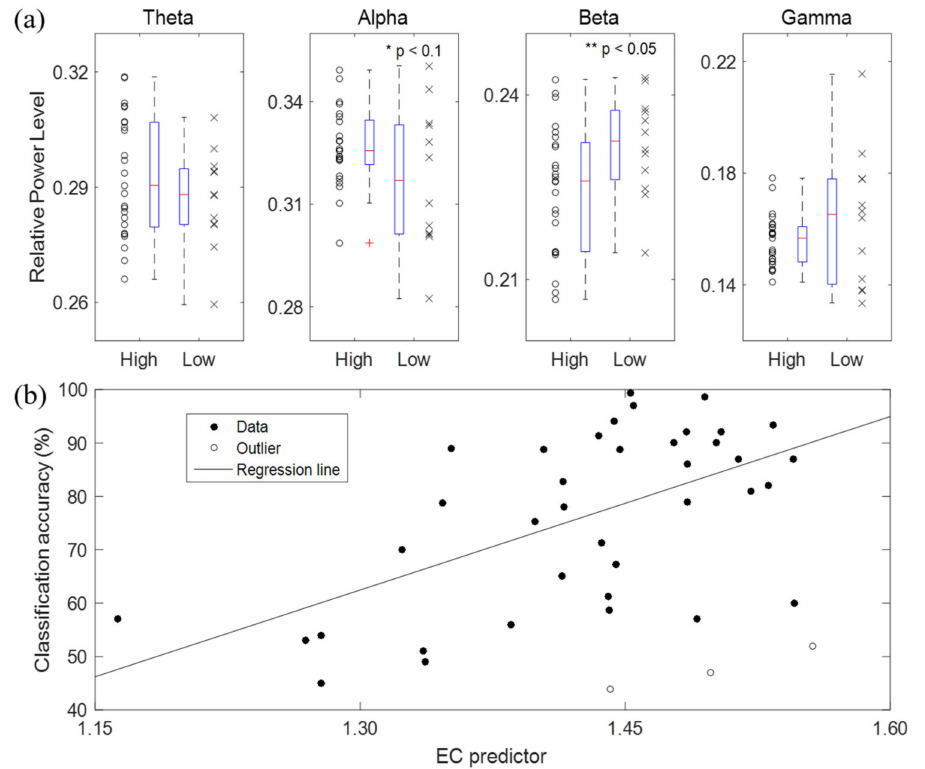
Figure 3. Eyes-closed resting state: ( a ) The relative power level (RPL) distributions of theta, alpha, beta, and gamma powers between the high- and low-performance groups. ( b ) Regression analysis between the EC predictor with two frequency bands (alpha and beta) and online BCI classification